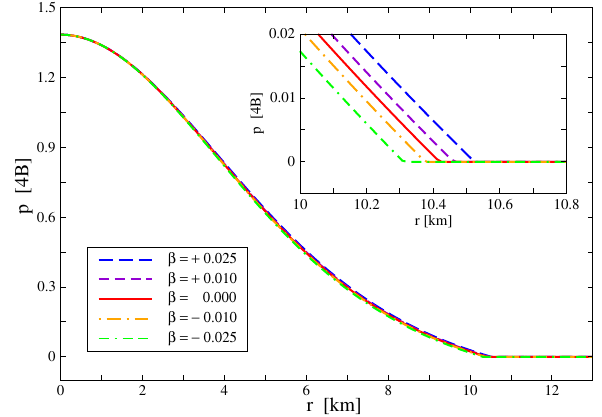
Fig. 1 Radial profile of pressure p ( r ) for different values of β ( β = 4 B ω ) with central density ρ c = 2 . 5414 × 10 15 g cm − 3 . The inset shows the pressure profile near the stellar radius r s for different values of β